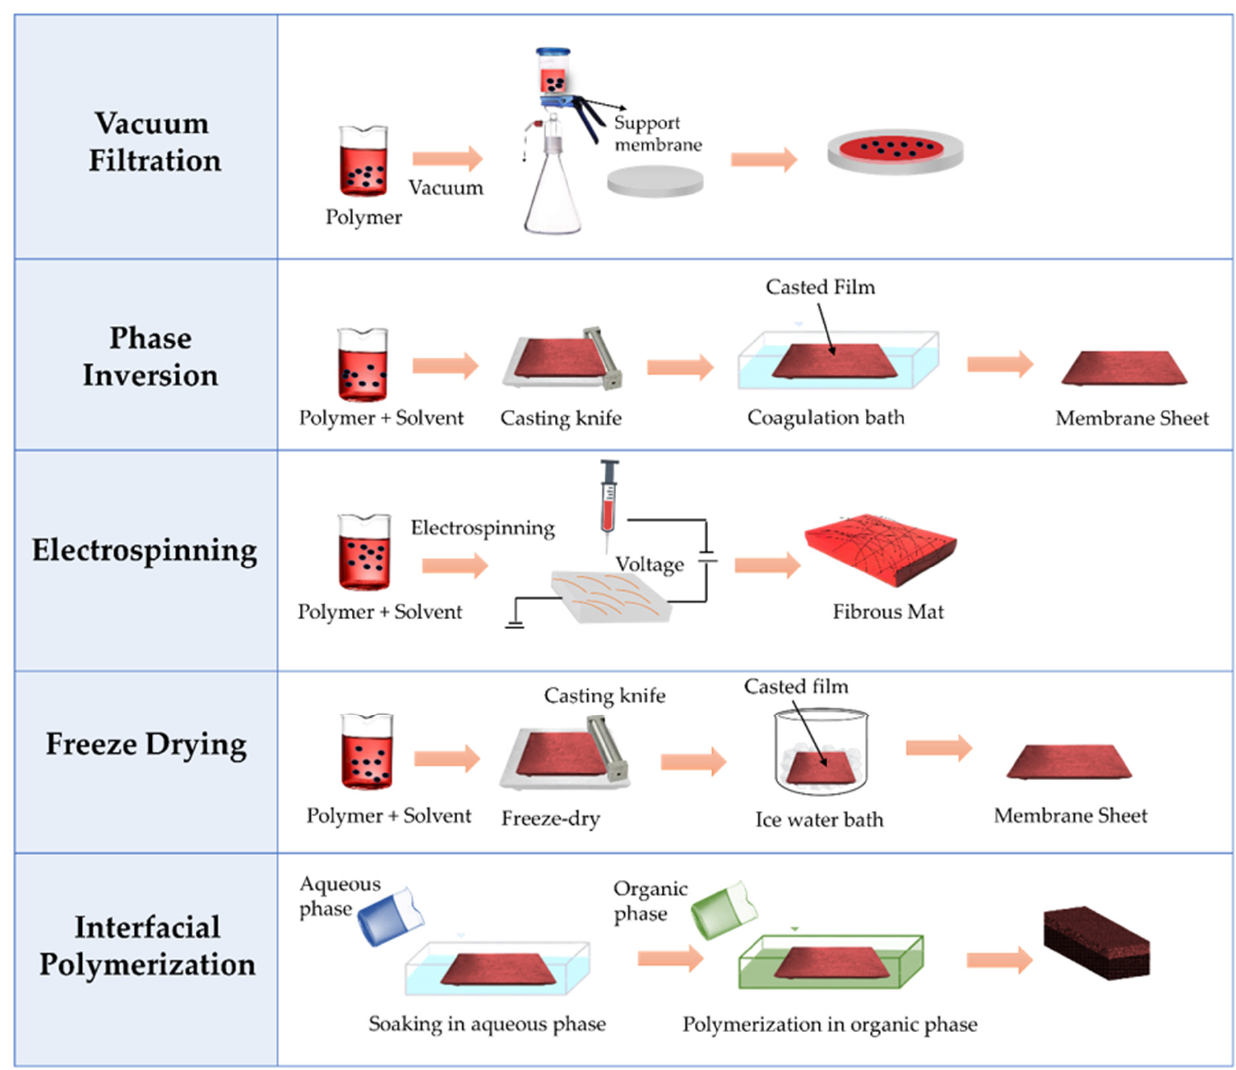
Figure 9. General procedures for the development of nanocellulose ‐ based membranes through vacuum filtration, phase inversion, electrospinning, freeze drying, and interfacial polymerization.